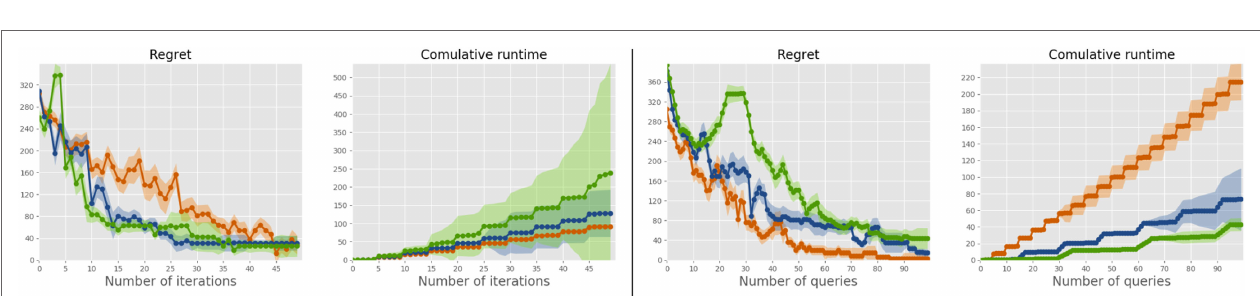
FIGURE 3 | Comparison between SM (orange) and the Bayesian competitors on users with sparse preferences.